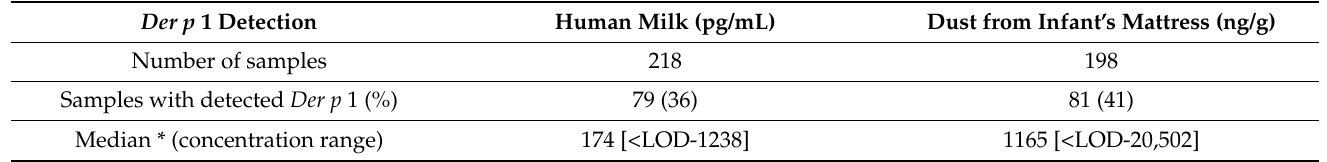
Table 2. Distribution of Der p 1 levels in human milk and dust samples collected from child’s mattress. Der p 1 Detection Human Milk (pg/mL) Dust from Infant’s Mattress (ng/g) Number of